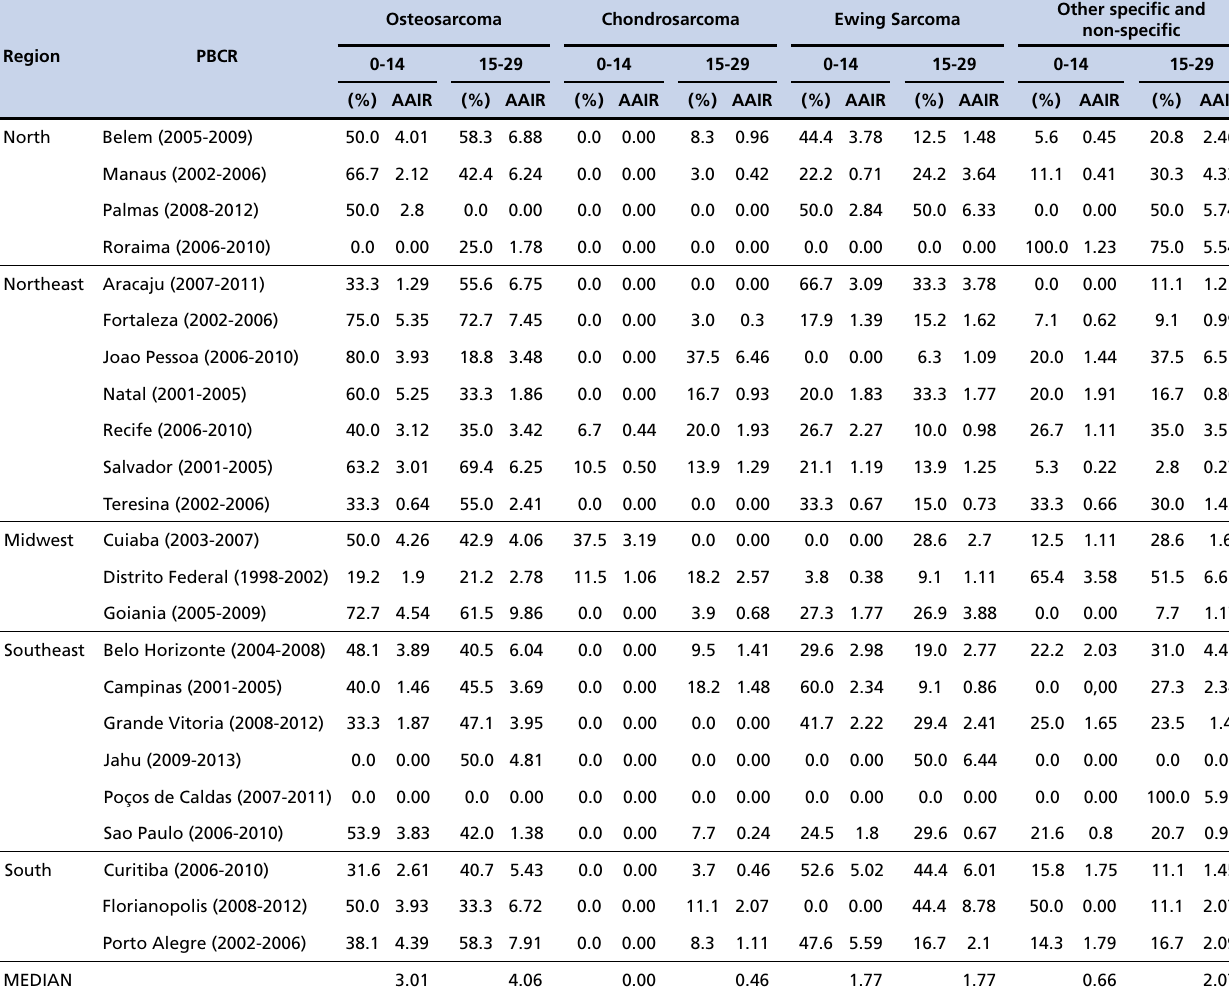
Table 2 – Distribution and age-ajusted incidence rates (AAIR) of morphological subtypes of bone tumors in children, adolescents and young adults, according to age group and